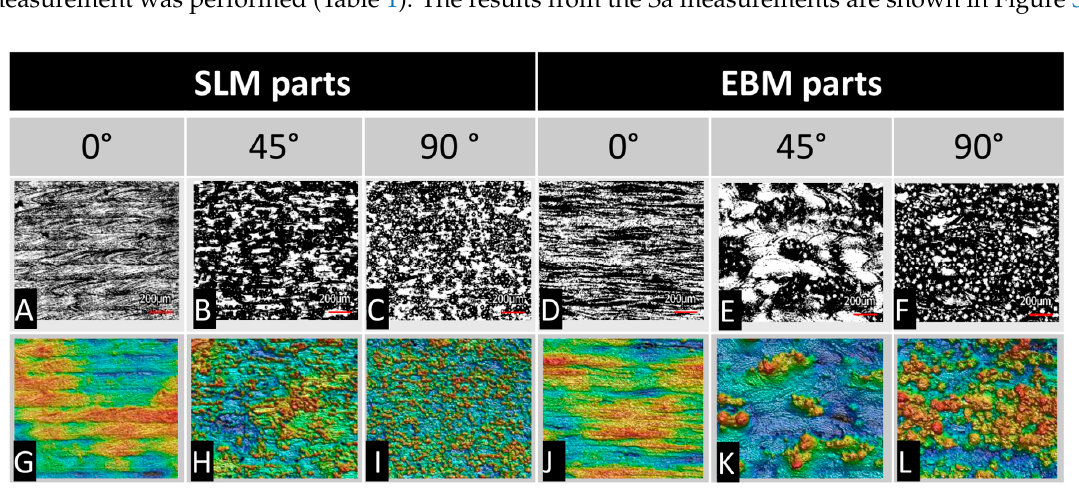
Figure 2. Overview of the surface characteristics of the measured surfaces on manufactured specimens in relation to the build orientation (0°, 45° and 90°) and the manufacturing process (selective laser melting, SLM; electron beam melting, EBM). The pictures in the first row ( A – F ) represent the optical surfaces (bar: 200 µm) which are displayed as false-color images in the row below ( G – L ). The highest position is displayed in red, while the lowest position is displayed in blue. Table 1. Results from roughness measurements (Ra)—lengthwise and transverse—as well as the average arithmetic height (Sa) of the surface ( n = 5).